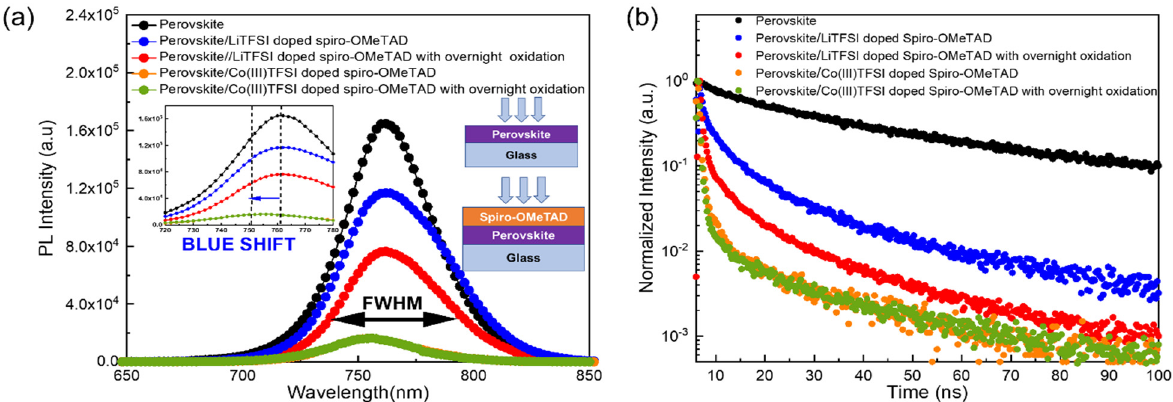
Figure 2. Photoluminescence spectra of the perovskite, perovskite coated with LiTFSI-doped spiro- OMeTAD, and perovskite coated with Co(III)TFSI co-doped spiro-OMeTAD on a glass substrate. The doped spiro-OMeTAD films are subjected to different oxidation conditions. ( a ) Steady-state PL. The inset shows the enlarged spectrum of PL between 720 and 780 nm to depict the blue shift. ( b ) TRPL .